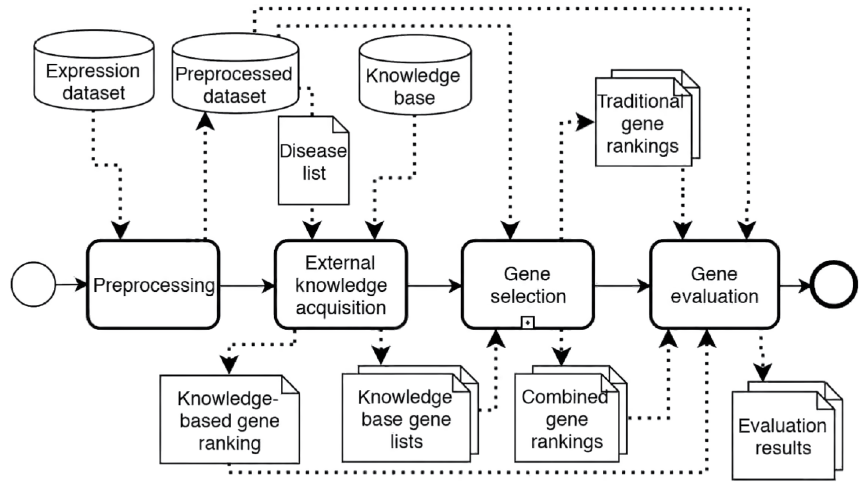
Figure 1: Overview on the analysis process carried out by our framework. It splits up into distinct steps of preprocessing, external knowledge acquisition, gene selection, and gene